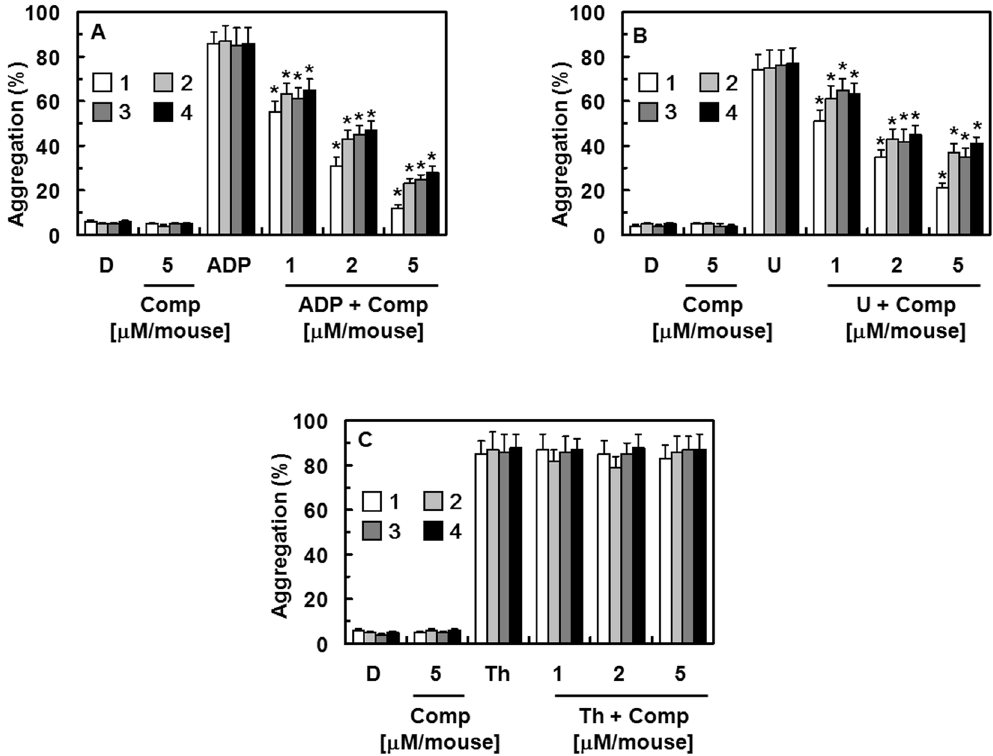
Figure 5. Effects of compounds 1–4 on agonist-induced platelet aggregation in vitro . Platelet-rich plasma ( PRP) was preincubated for 5 min with different concentrations of compounds 1 – 4 , or vehicle. Platelet aggregation was initiated with ADP (A, 10 µ M), U46619 (B, 6 µ M), or thrombin (C, 3 U/mL). D = 0.2% DMSO used as the vehicle control. Data are presented as means ± SD of three independent experiments. * p < 0.05 vs. vehicle alone, analyzed by one-way ANOVA, followed by Tukey multiple comparison